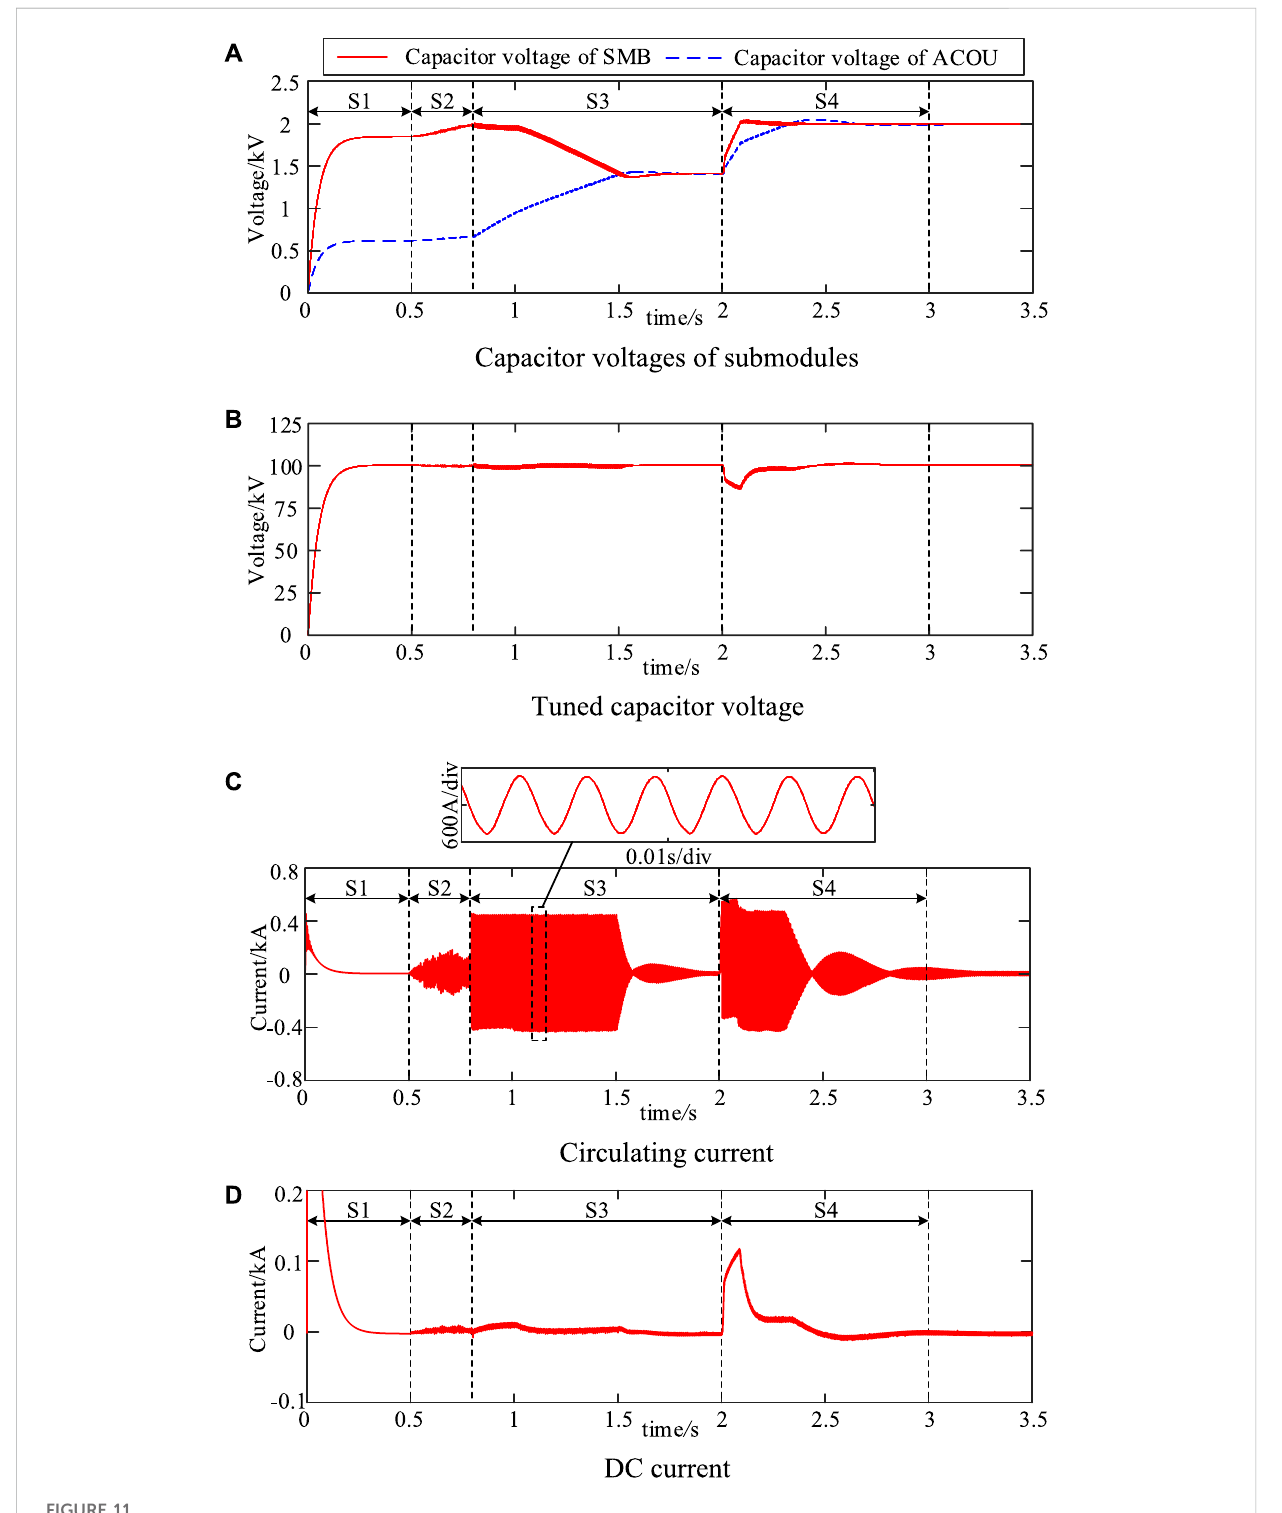
FIGURE 11 Simulation results during the start-up process. (A) Capacitor voltages of submodules. (B) Tuned capacitor voltage. (C) Circulating current. (D) DC